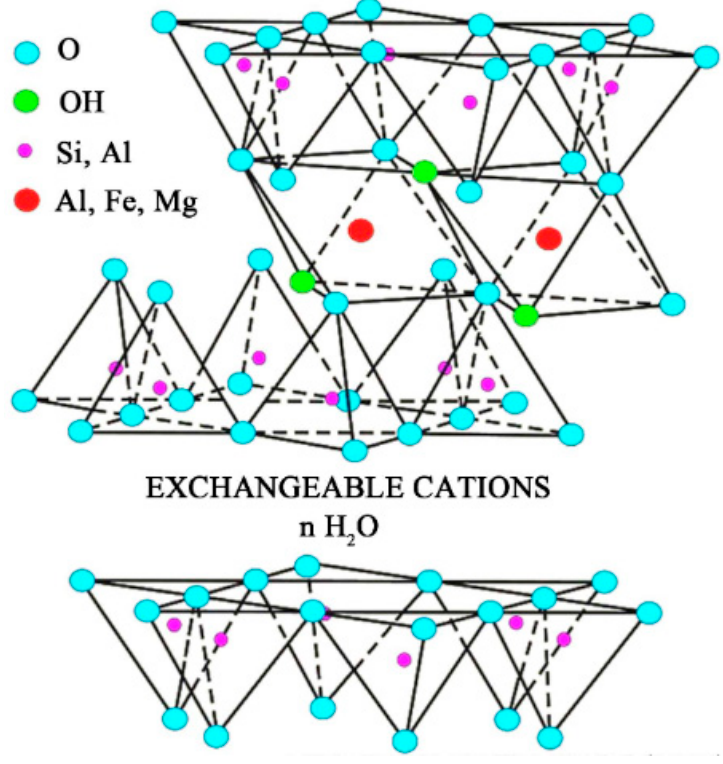
Figure 4. Representative structure of montmorillonite clay [119].